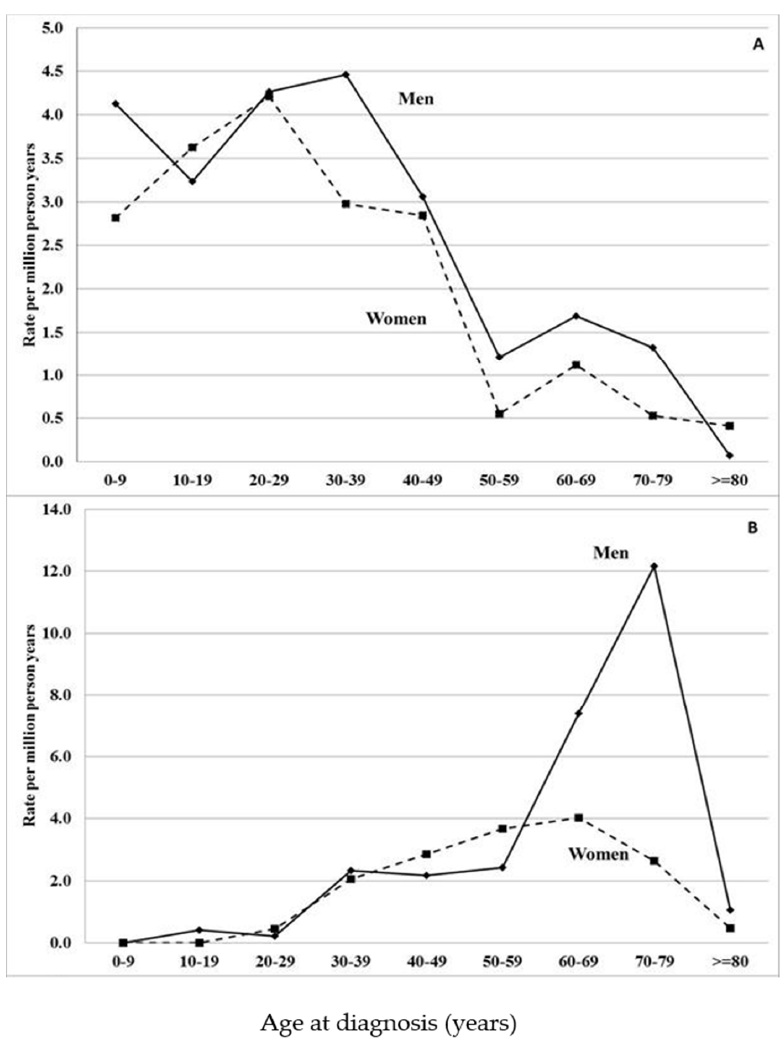
Figure 1. Age-specific incidence rates (per million person–years) for amyloidosis subtypes in Swe- den (1997–2008), ( A ) ‘non-neuropathic heredofamilial amyloidosis’ or autoinflammatory disease (E85.0) and ( B ) ATTRv amyloidosis (familial amyloidotic polyneuropathy, E85.1). Modified from reference